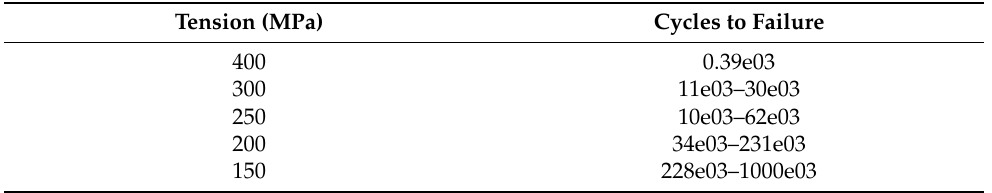
Table 2. Strength characteristics of the connection under cyclic loading.